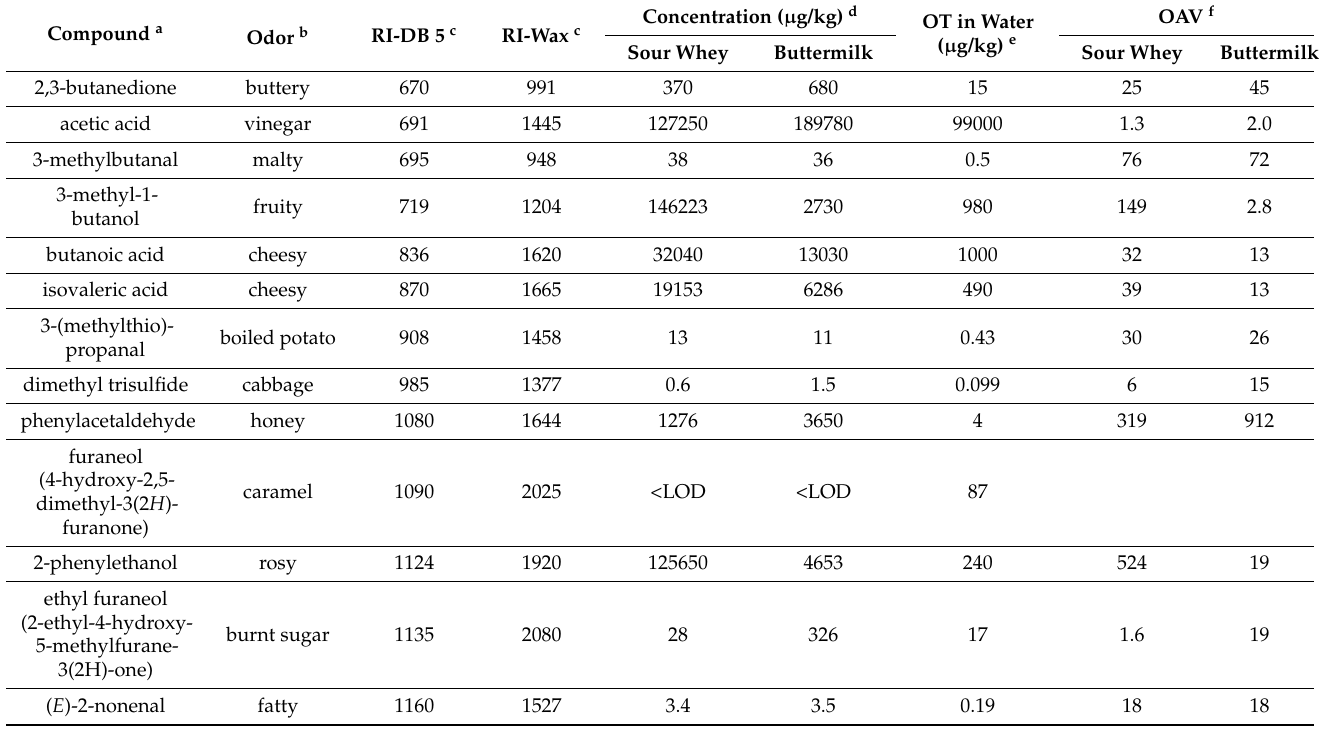
a Compounds identified by comparison with reference compounds based on the following criteria: retention index (RI), mass spectra obtained by MS (EI), and odor quality at the sniffing port. b Odor perceived at the sniffing port. c Retention indices on DB-5